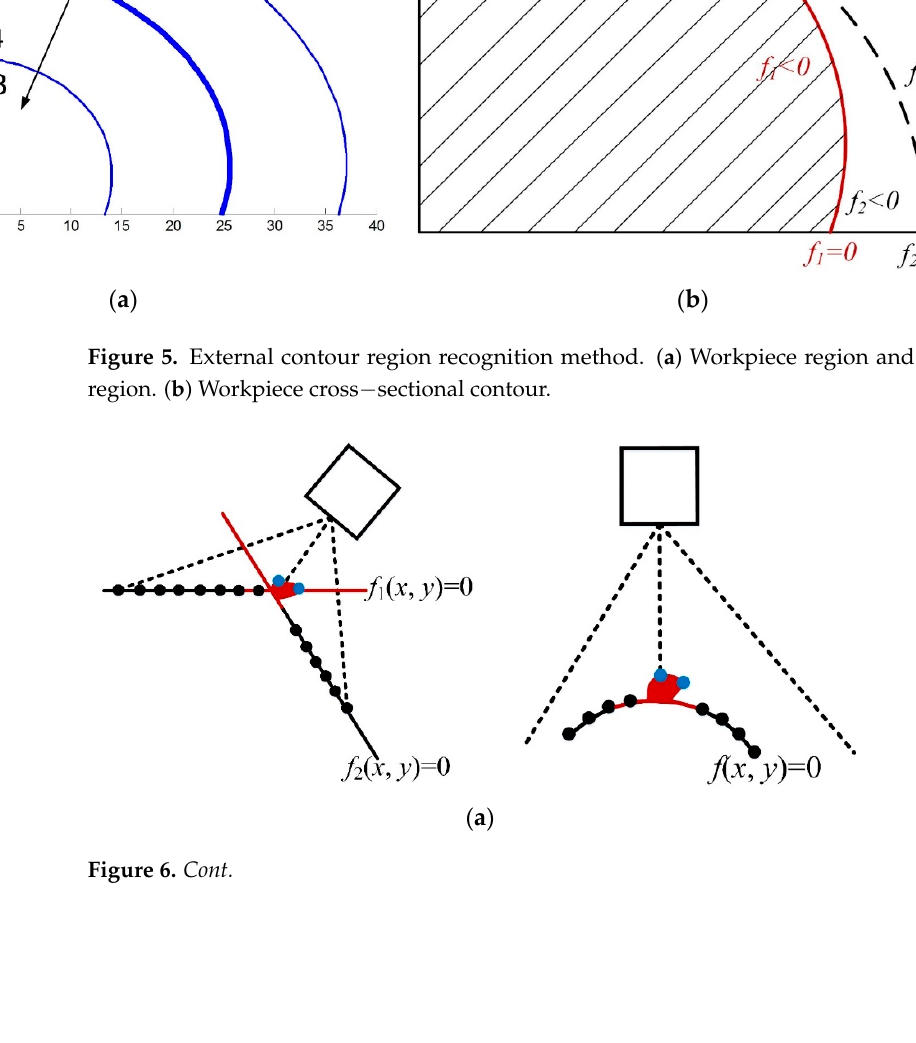
Figure 5. External contour region recognition method. ( a ) Workpiece region and environmental region. ( b ) Workpiece cross − sectional contour.